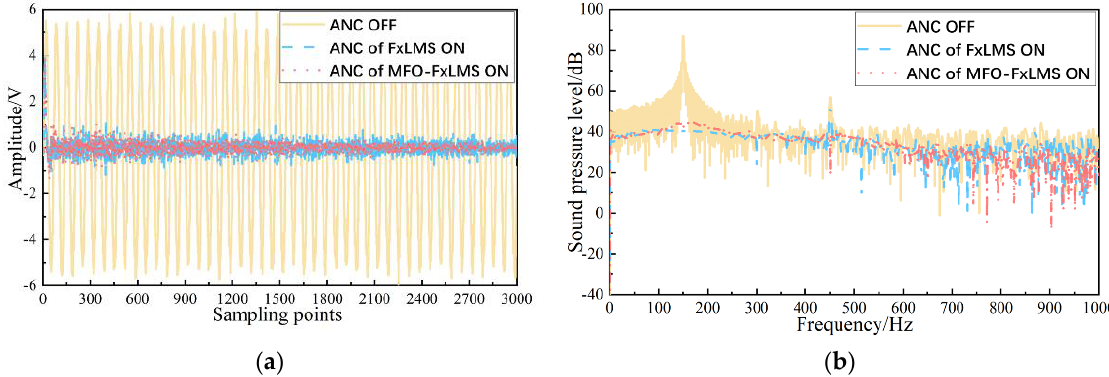
Figure 4. Comparison of noise cancellation performance of two algorithms: ( a ) Time domain dia- gram; ( b ) Frequency domain diagram.